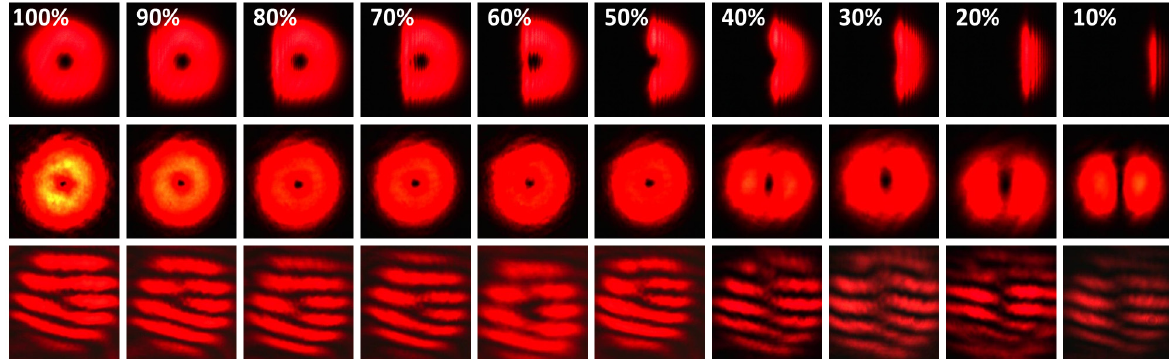
Fig. 3 | CCD captured experimental results . The first row shows the intensity distribution of the beams incident on the FP cavity with different unblocking percentages from 100% to 10%. The second row shows the intensity distribution of the transmitted light from the FP cavity with the resonant cavity length of the LG 01 beams. The third row shows the interference patterns between the transmitted light and the reference Gaussian